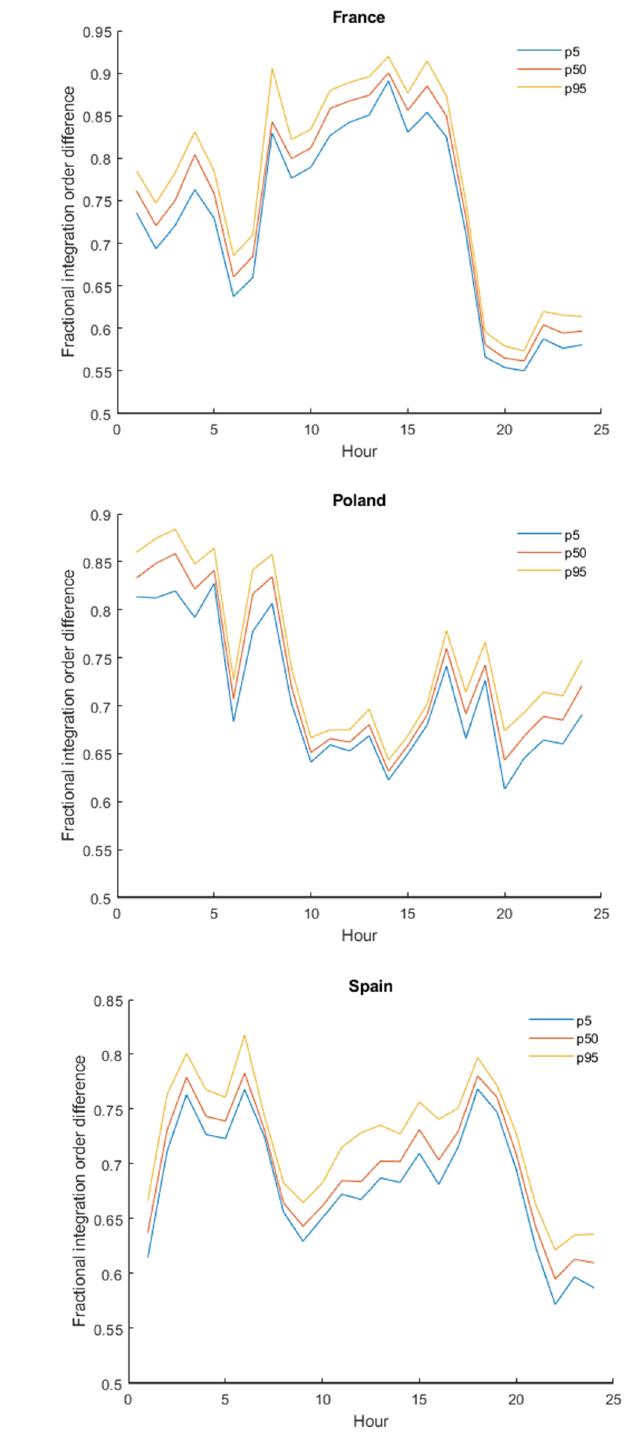
Figure 2. Reduction in price persistence levels.